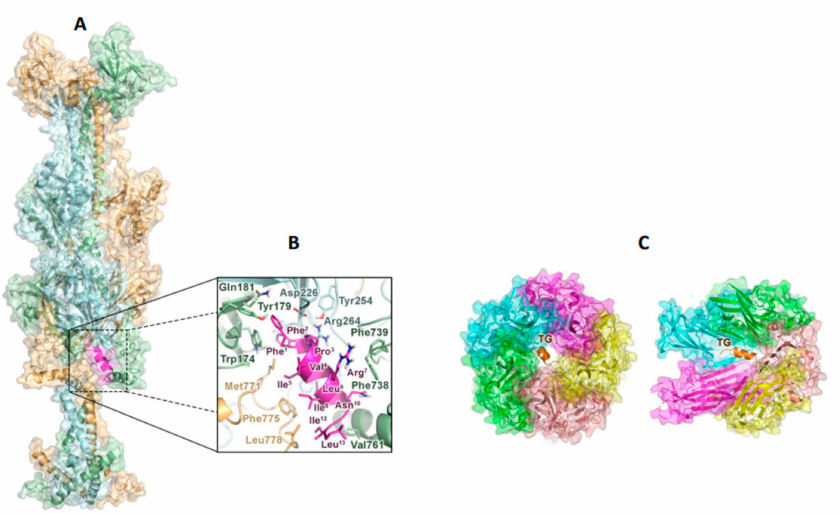
Figure 4. Computational studies indicating putative TG binding with HSV-1 glycoprotein-B and with JCPyV VP1 protein. ( A ) Model complex of the gB trimer and TG: gB is shown as a ribbon and in surface representations (the three monomers are in light orange, light green, and light cyan), while TG is shown as a magenta ribbon. ( B ) TG within the binding site of gB. Side chain of interacting residues are shown as sticks. For the sake of clarity here and throughout the manuscript, the residue numbers of the peptide are reported as an apex, while those of the receptor are not. ( C ) Upper (left panel) and side (right panel) view of the predicted TG/VP1 binding complex. TG is depicted in orange, while the VP1 pentamer subunits are shown in green, cyan, magenta, yellow, and pink and as a transparent surface. To gain insights into the mechanism of action of TG in the JCPyV fusion process, the